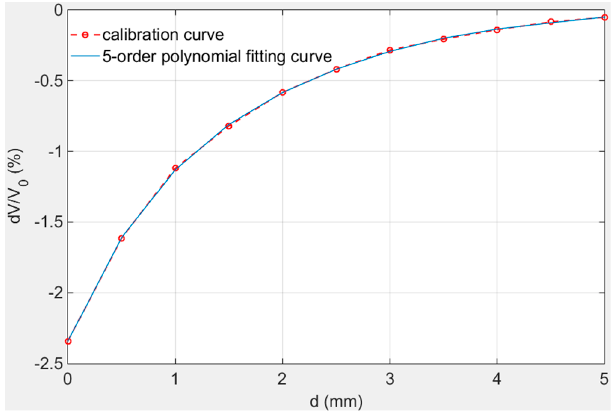
Figure 9. Calibration curve at room temperature.